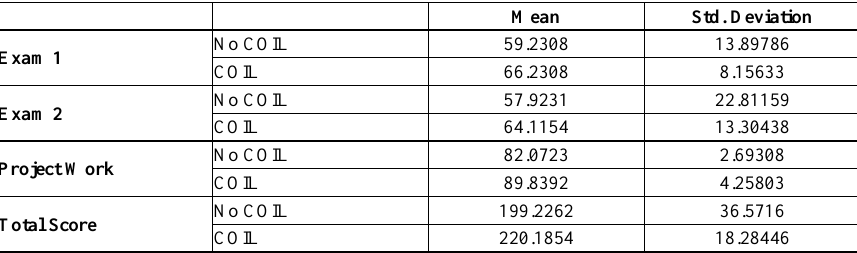
Table 1. The mean and standard deviation of